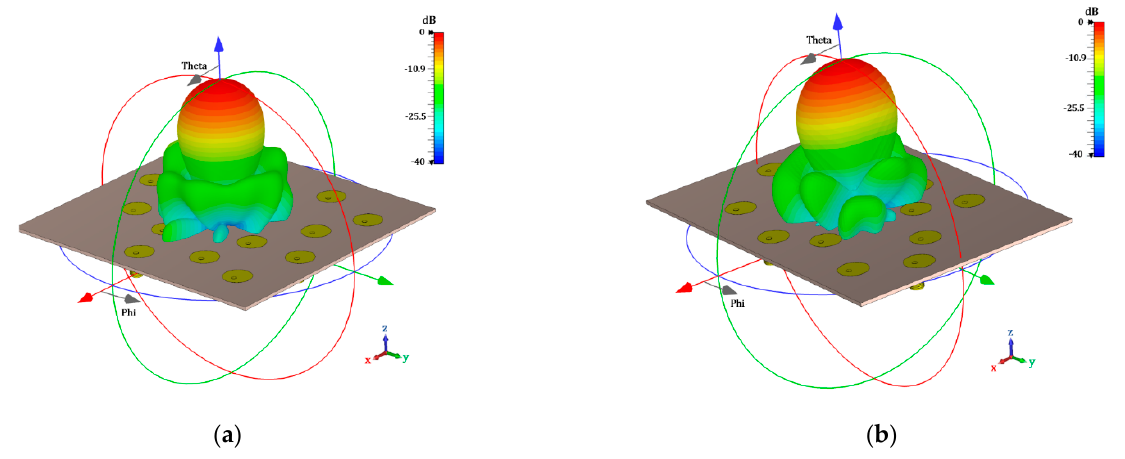
Figure 10. Radiation pattern obtained by full-wave simulation for the cases of using uniform ampli- tude excitation, as follows: ( a ) golden angle and ( b ) optimization of angular separations.